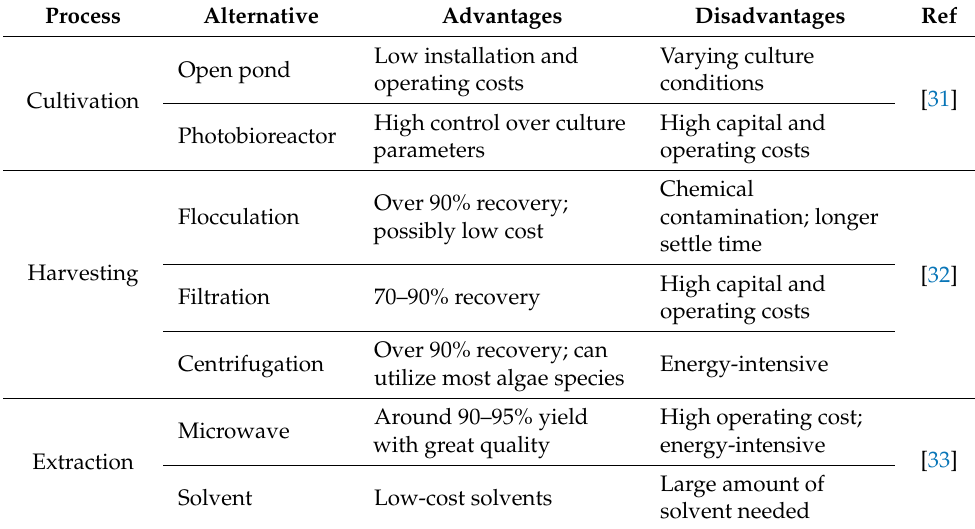
Table 1. Comparison of the different process unit